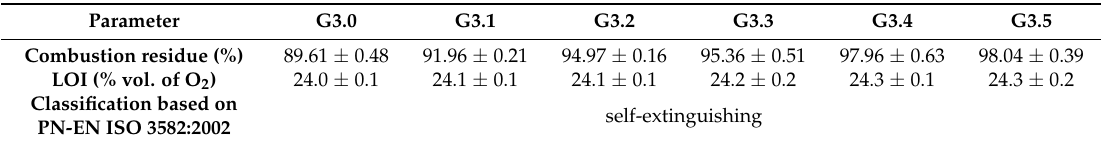
Table 7. Flammability tests results.